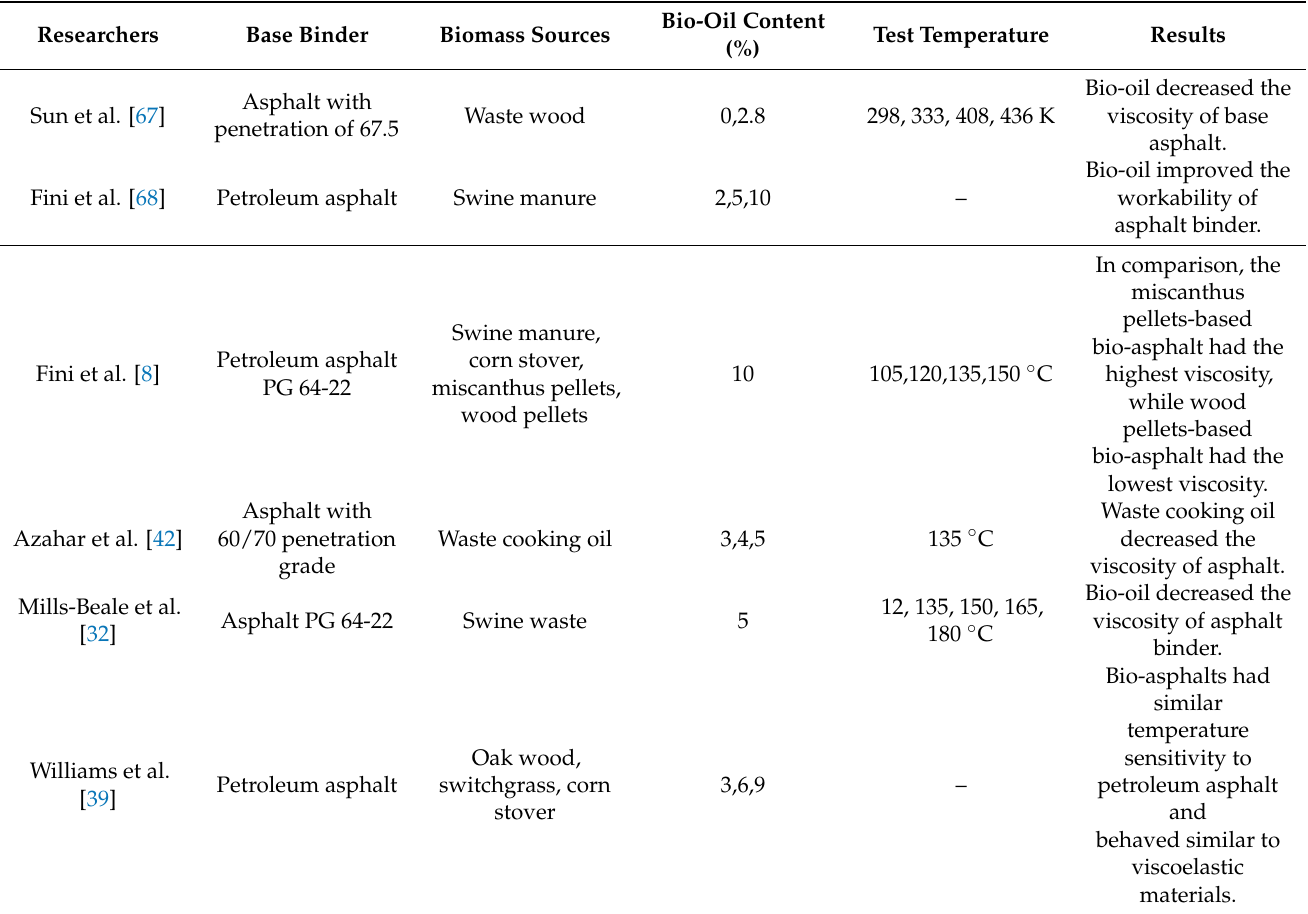
Table 6. Viscosity and workability of bio-oil modified